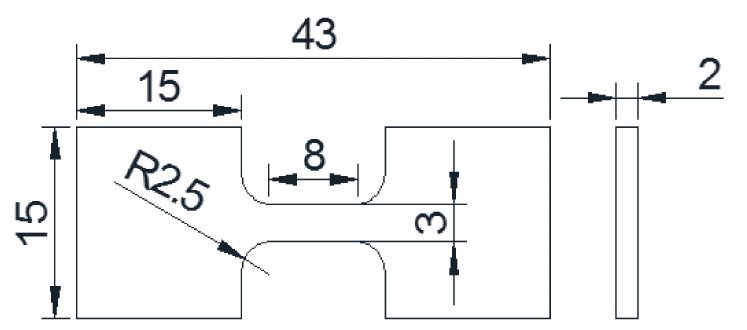
Figure 1. The shape of tensile samples.